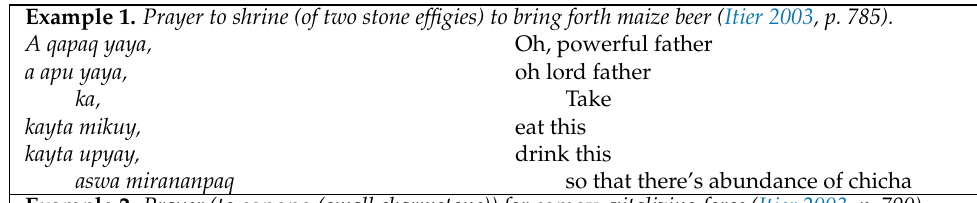
Table 2. Examples of addresses to ancestral instantiations (the original Quechua in